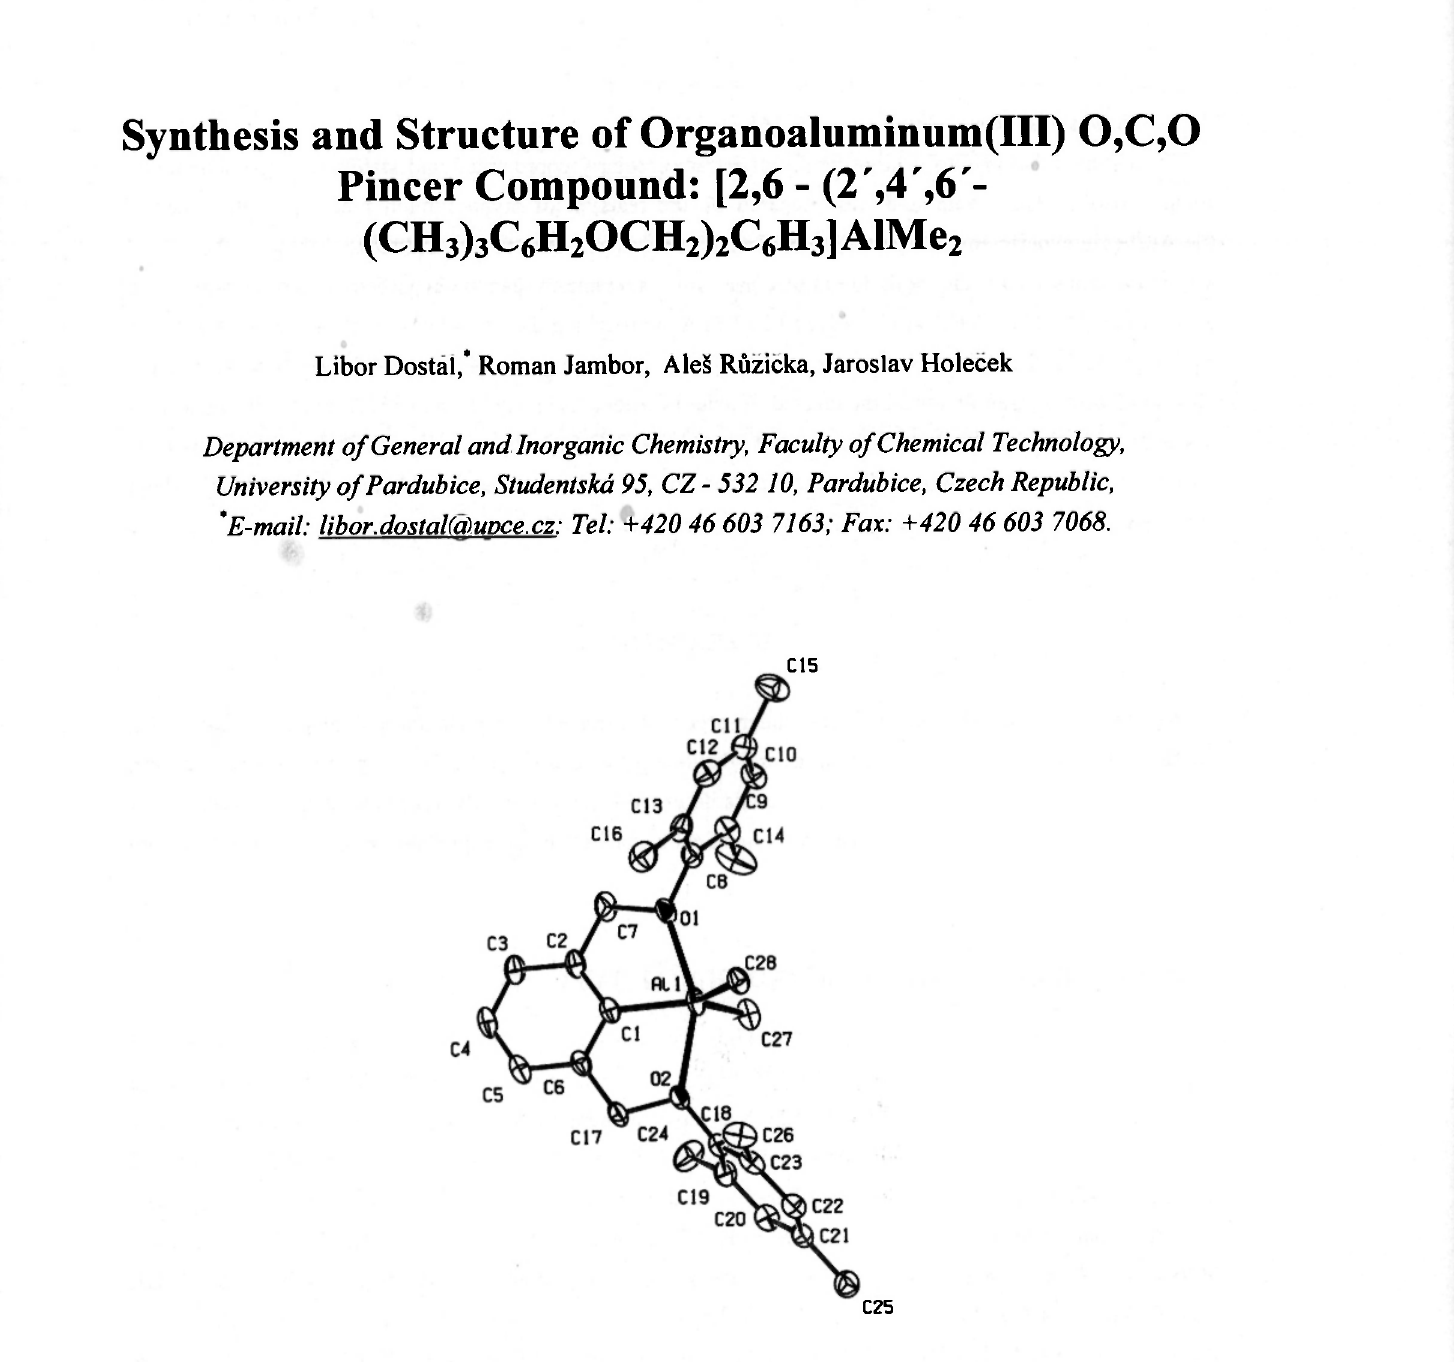
Figure 1. Molecular structure of 1 (hydrogen atoms are omitted for clarity, 50% ellipsoids): Key geometric parameters